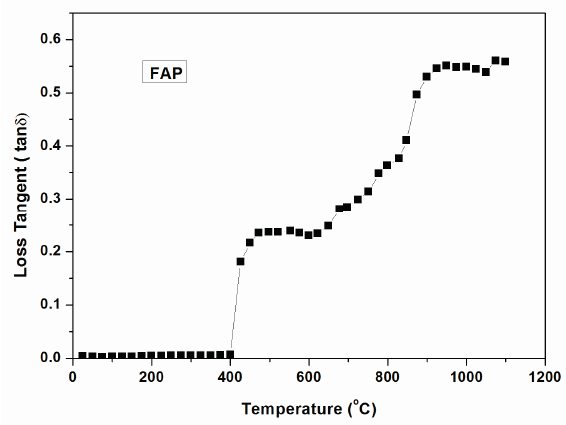
Figure 13. Dielectric loss tangent of FAP powdered glass batch with temperature (~1000 °C).